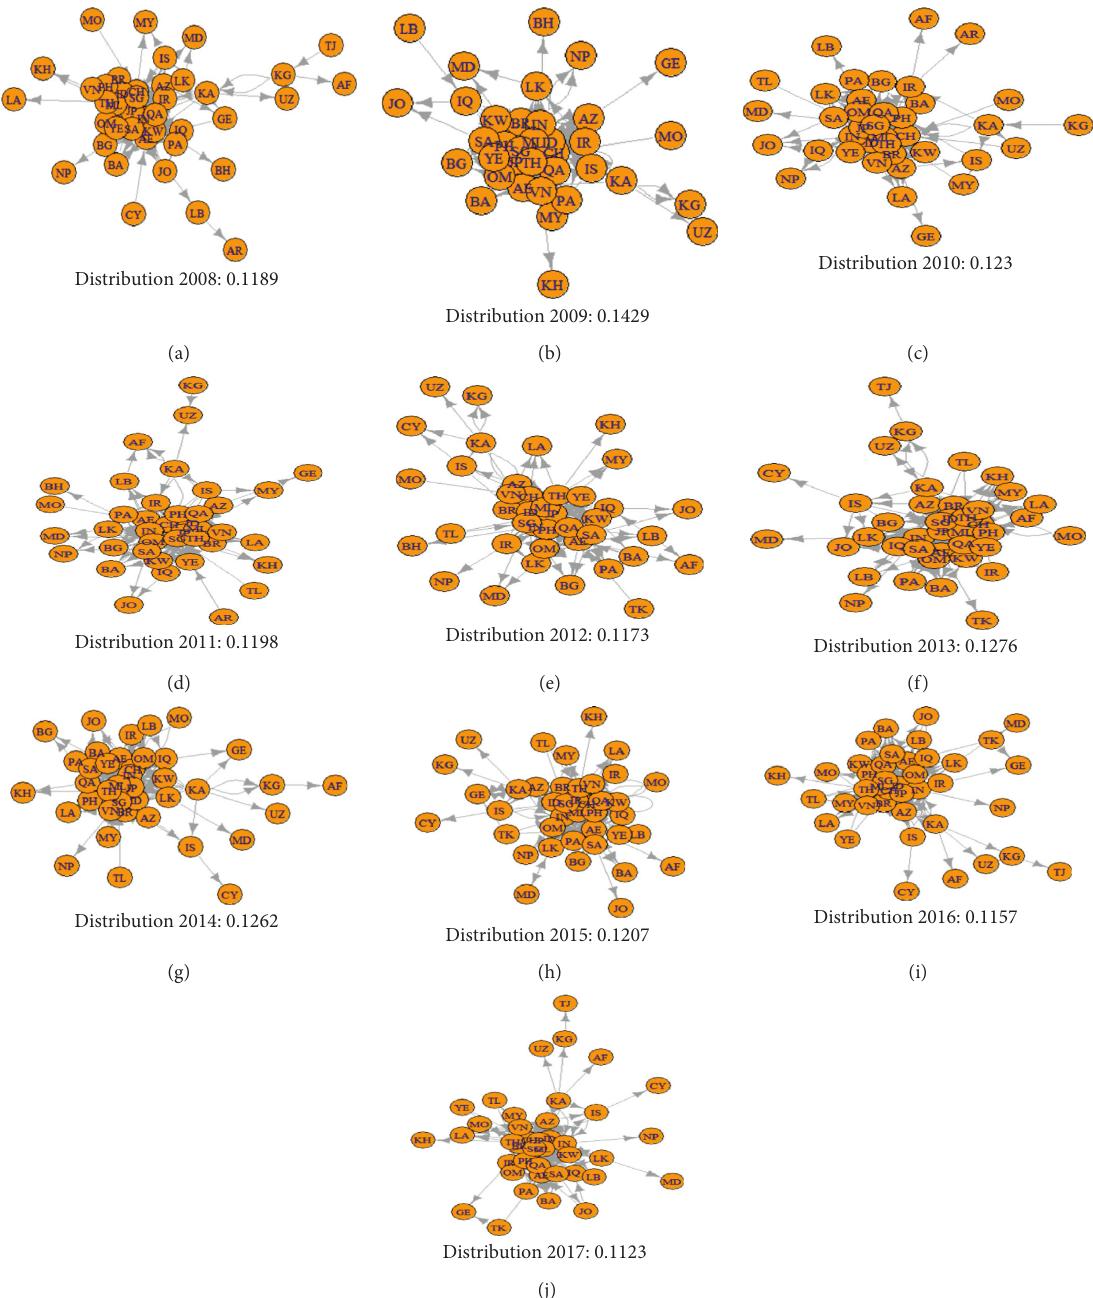
Figure 2: Network structure of Asian oil import and export market. Source: results calculated from the software STATA 16.0. (a) Distribution 2008: 0.1189 (b) Distribution 2009: 0.1429 (c) Distribution 2010: 0.123 (d) Distribution 2011: 0.1198 (e) Distribution 2012: 0.1173 (f) Distribution 2013: 0.1276 (g) Distribution 2014: 0.1262 (h) Distribution 2015: 0.1207 (i) Distribution 2016: 0.1157 (j) Distribution 2017: